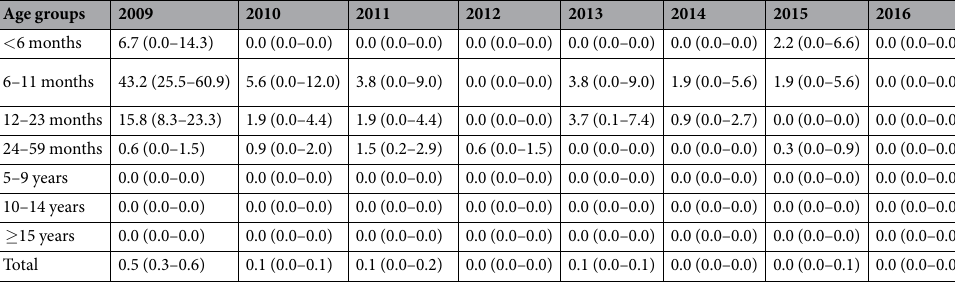
Table 3. Incidence rates of fatal cases of HFMD by age groups in Shandong province,